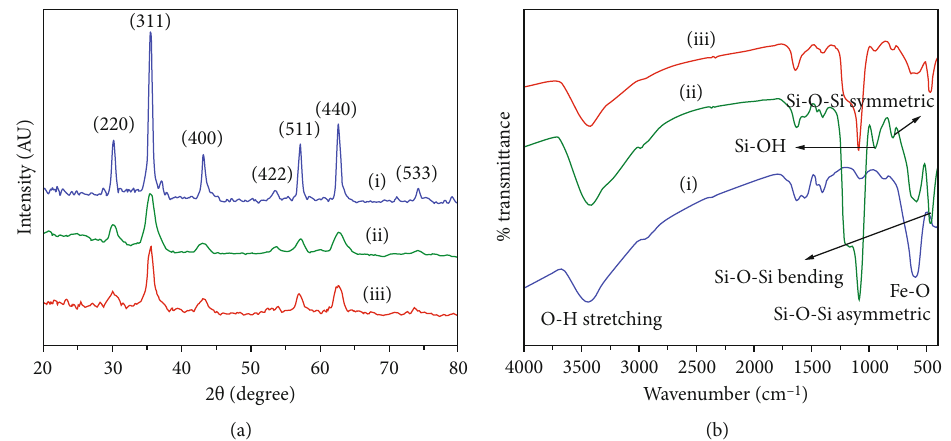
Figure 1: (a) XRD patterns and (b) FT-IR spectra of (i) Fe